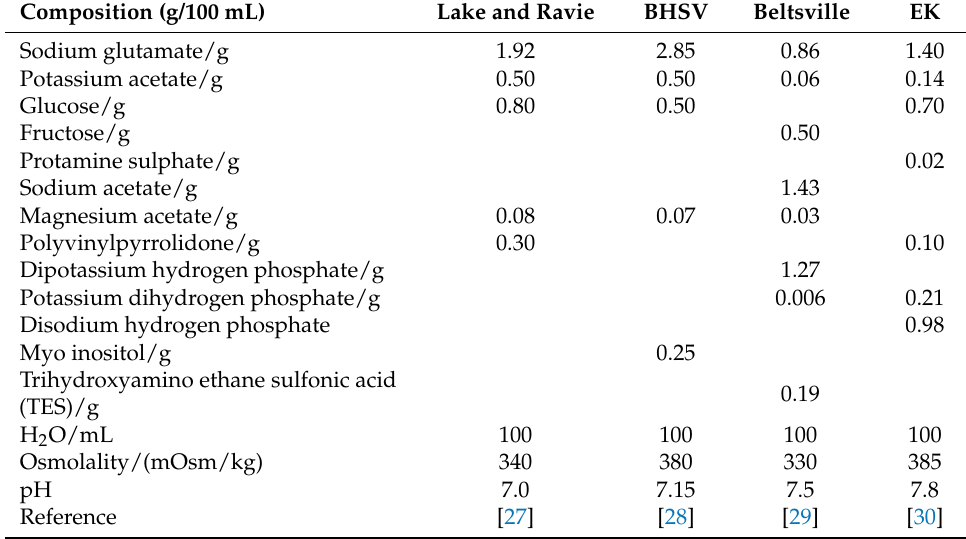
Table 2. The common diluents